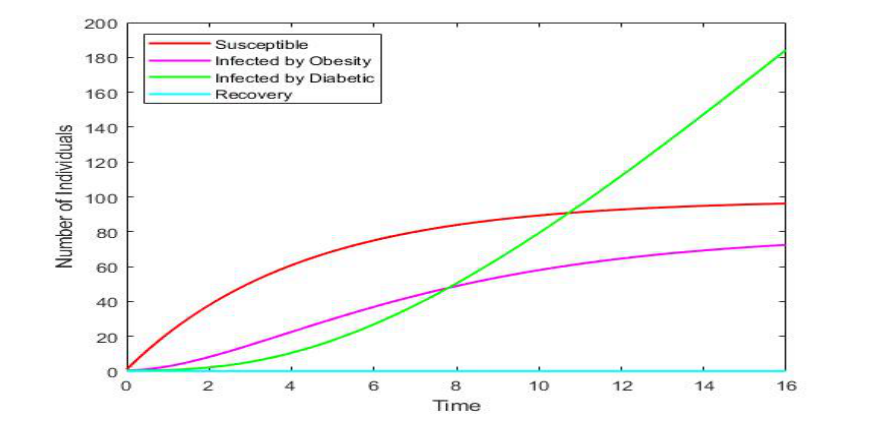
Figure 3: Obesity and Diabetic without control